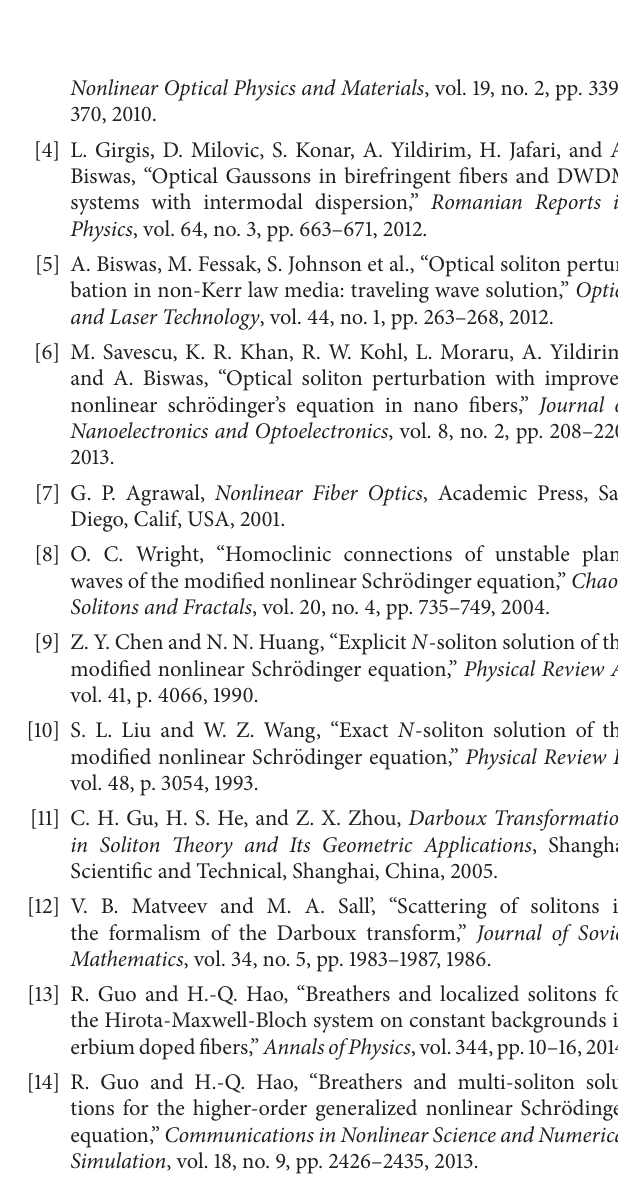
Figure 4: Evolution of the breather solutions of (1). Parameters are (a) 𝐴 𝑐 = 0.5 , 𝜅 1 = 1 , 𝜅 2 = 1 , 𝛿 = 1 and (b) 𝐴 𝑐 = 0.05 , 𝜅 1 = 1 , 𝜅 2 = 1 , 𝛿 = 1